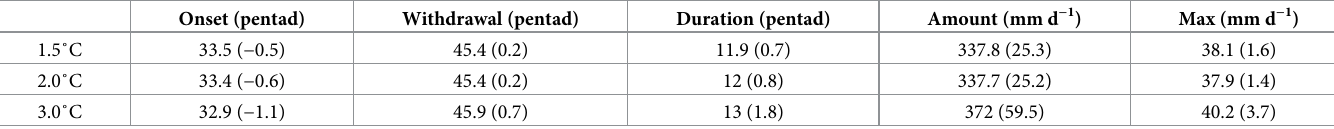
Table 3. The values for the characteristics of EASM under 1.5, 2.0, and 3.0˚C GWLs. The value in parenthesis is change in each warming period compared to the pres- ent day (PD) period. Onset